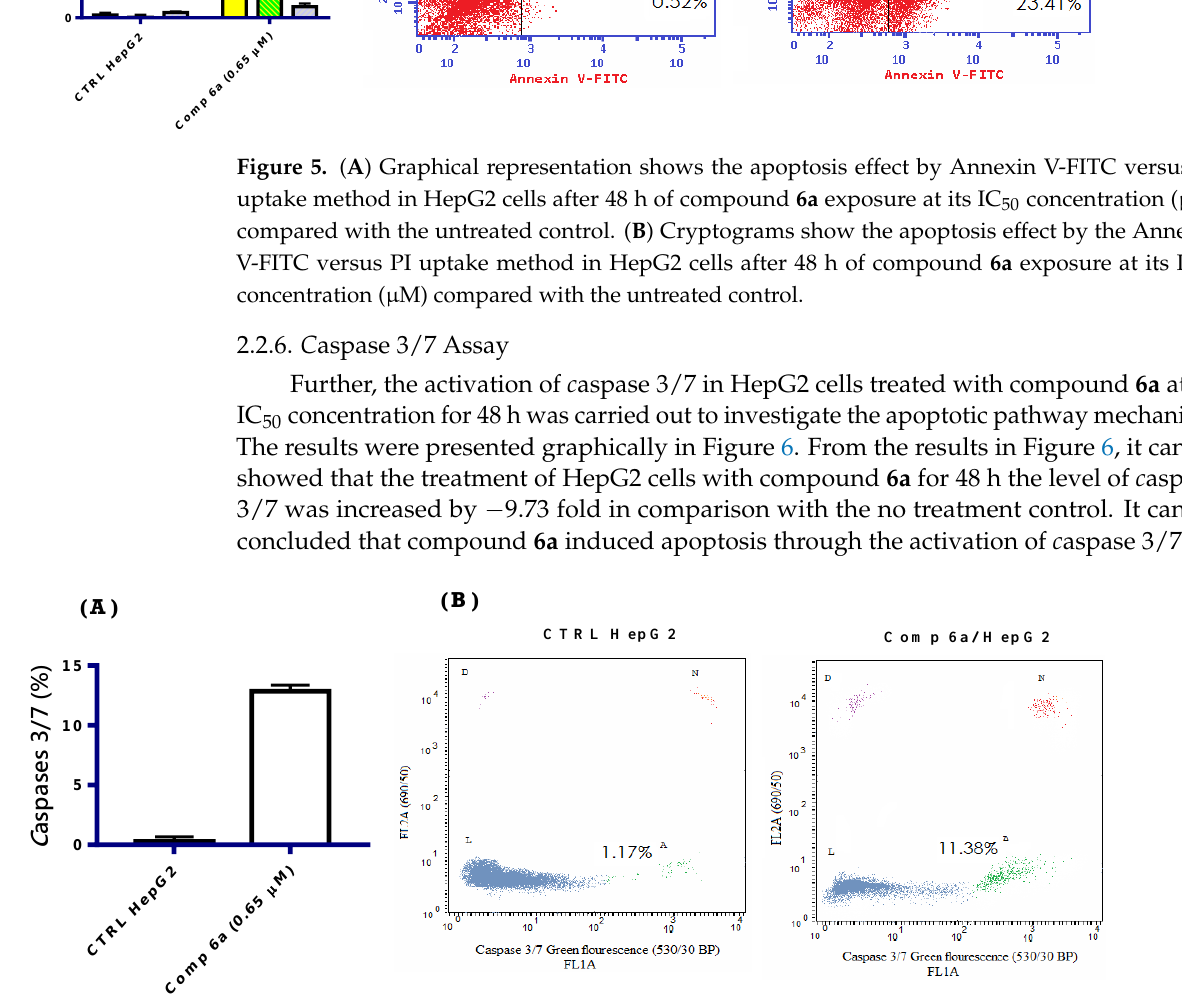
Figure 6. ( A ) Graphical representation of c aspase 3/7 in HepG2 cells after 48 h of compound 6a exposure at its IC 50 concentration ( μ M) compared with the untreated control. ( B ) Cryptograms show c aspase 3/7 in HepG2 cells after 48 h of compound 6a exposure at its IC 50 concentration ( μ M) com- pared with the untreated control. ment with compound 6a with the concentration induced cytotoxicity for 48 h. Results